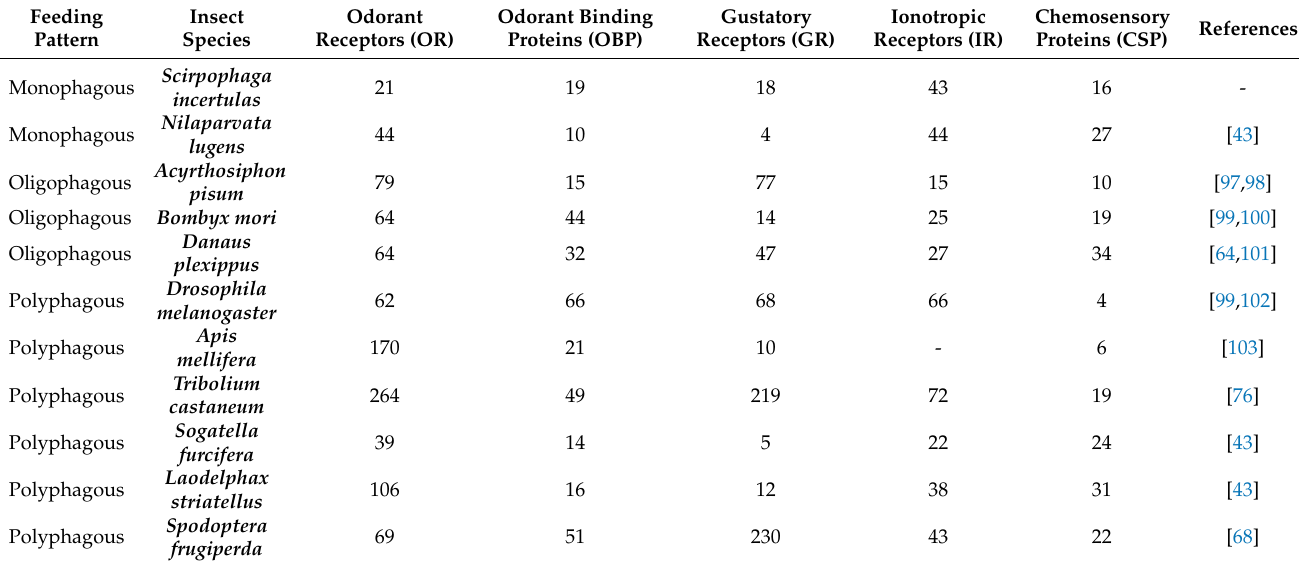
Table 6. Comparison of chemosensory